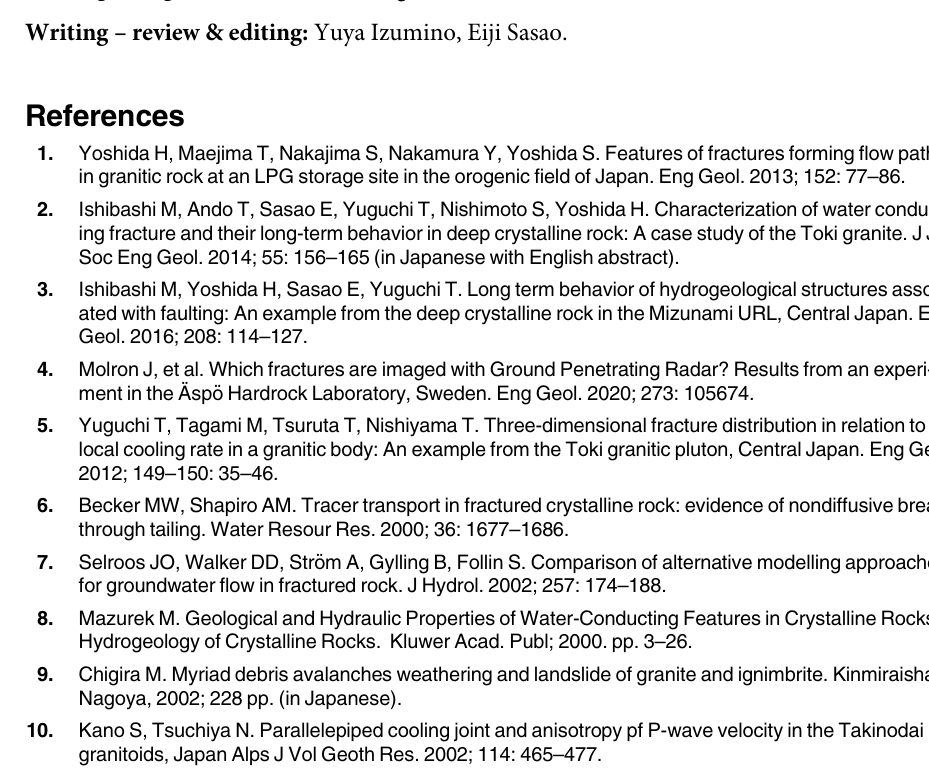
S4 Table. Pixels and area of microvoids in all chloritized biotites for samples No. A1-A12 and No. 1–12, leading to the areal fractions of